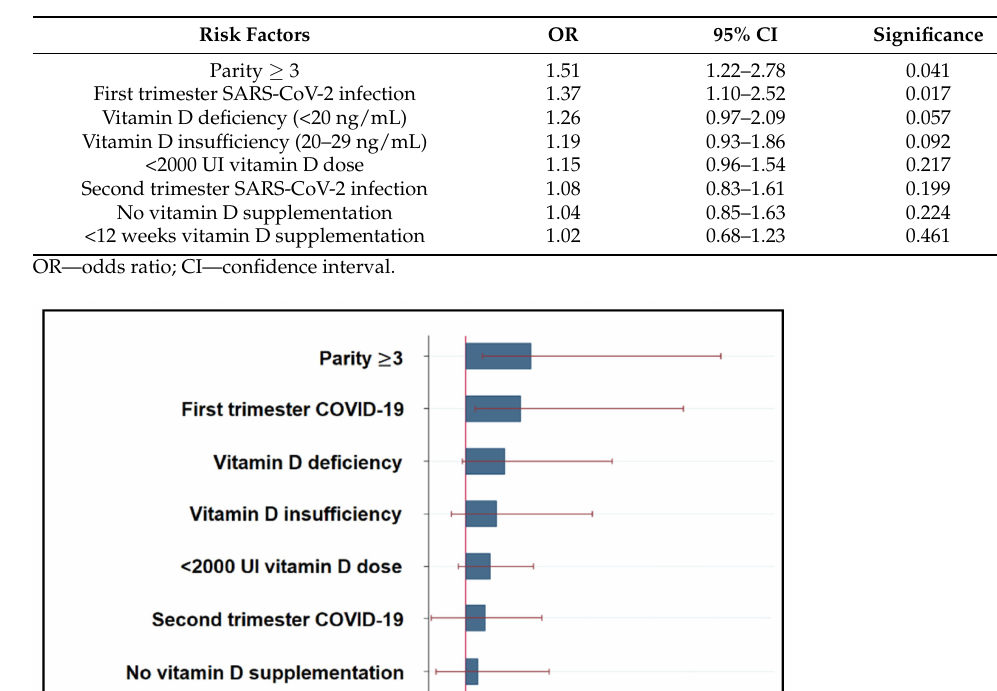
Table 5. Risk factor analysis for gestational hypertension.